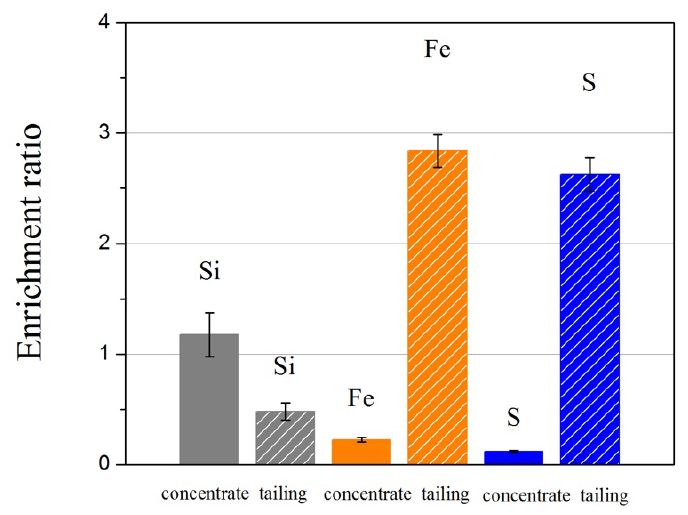
Figure 6. Enrichment ratio of Si, Fe, and S for the concentrated flotation samples.